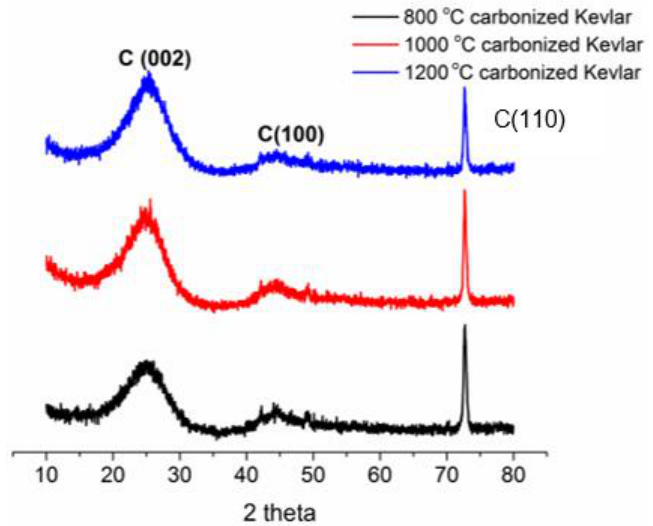
Figure 7. Effect of carbonization temperature on crystallinity of activated carbon fabric.